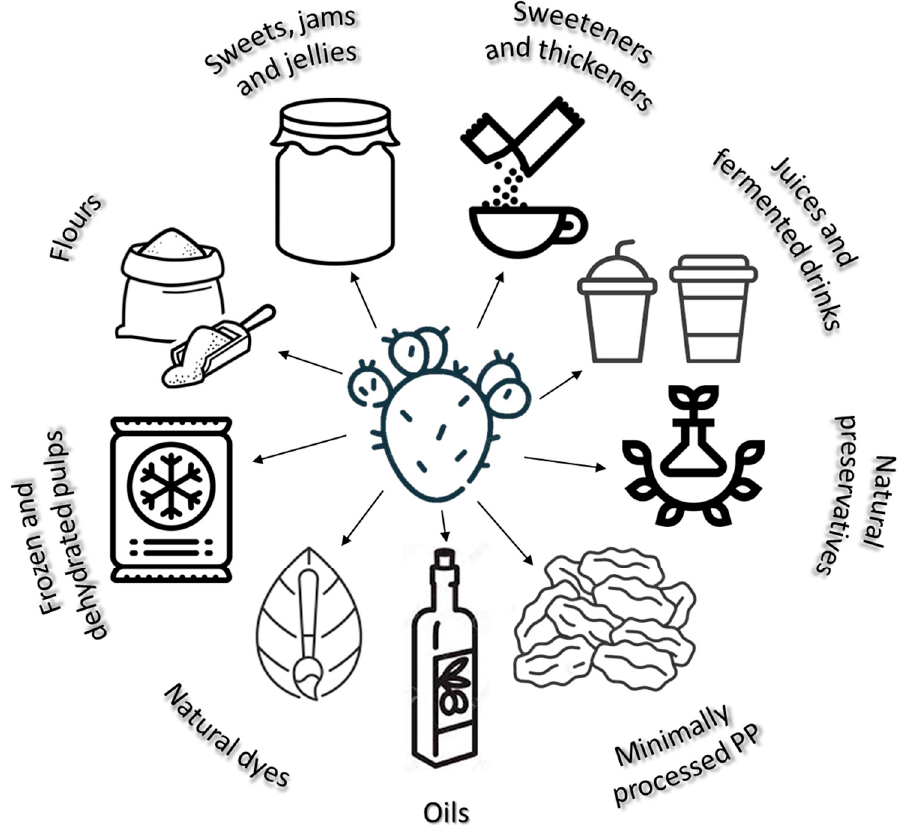
Figure 6. Products from conservation and transformation methods applied to the PP [5–8,129,130].